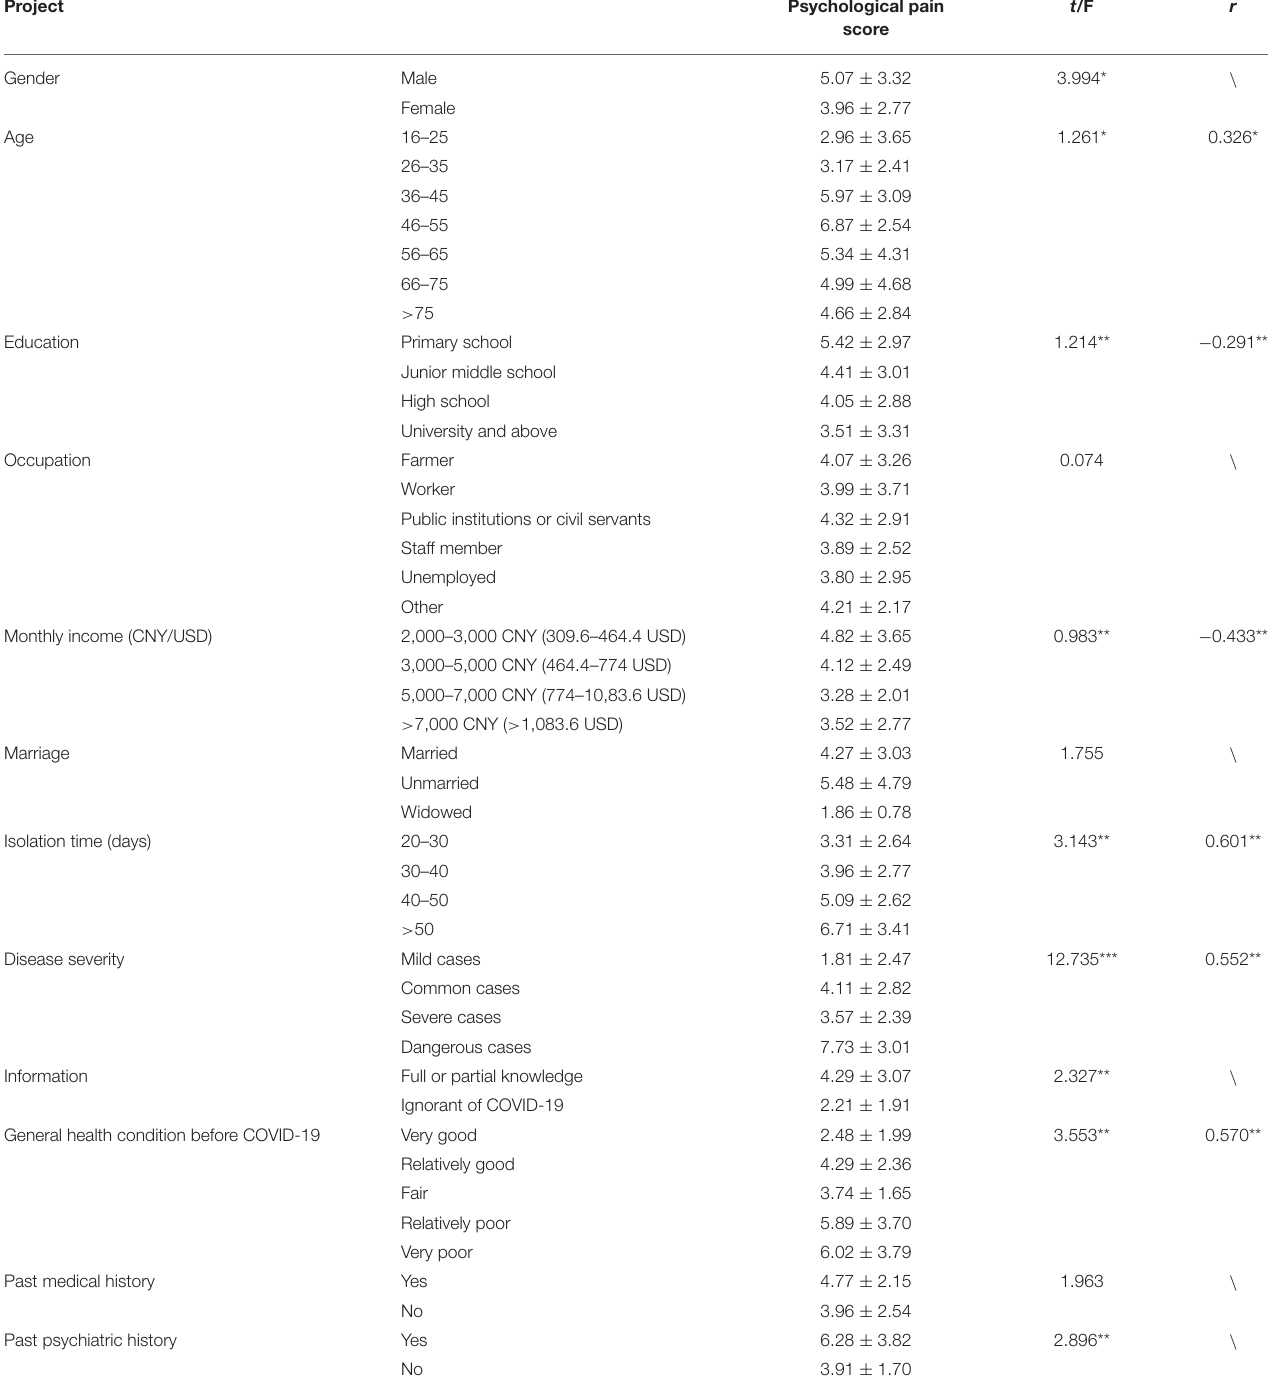
TABLE 4 | Comparison analysis of COVID-19 patients’ psychological